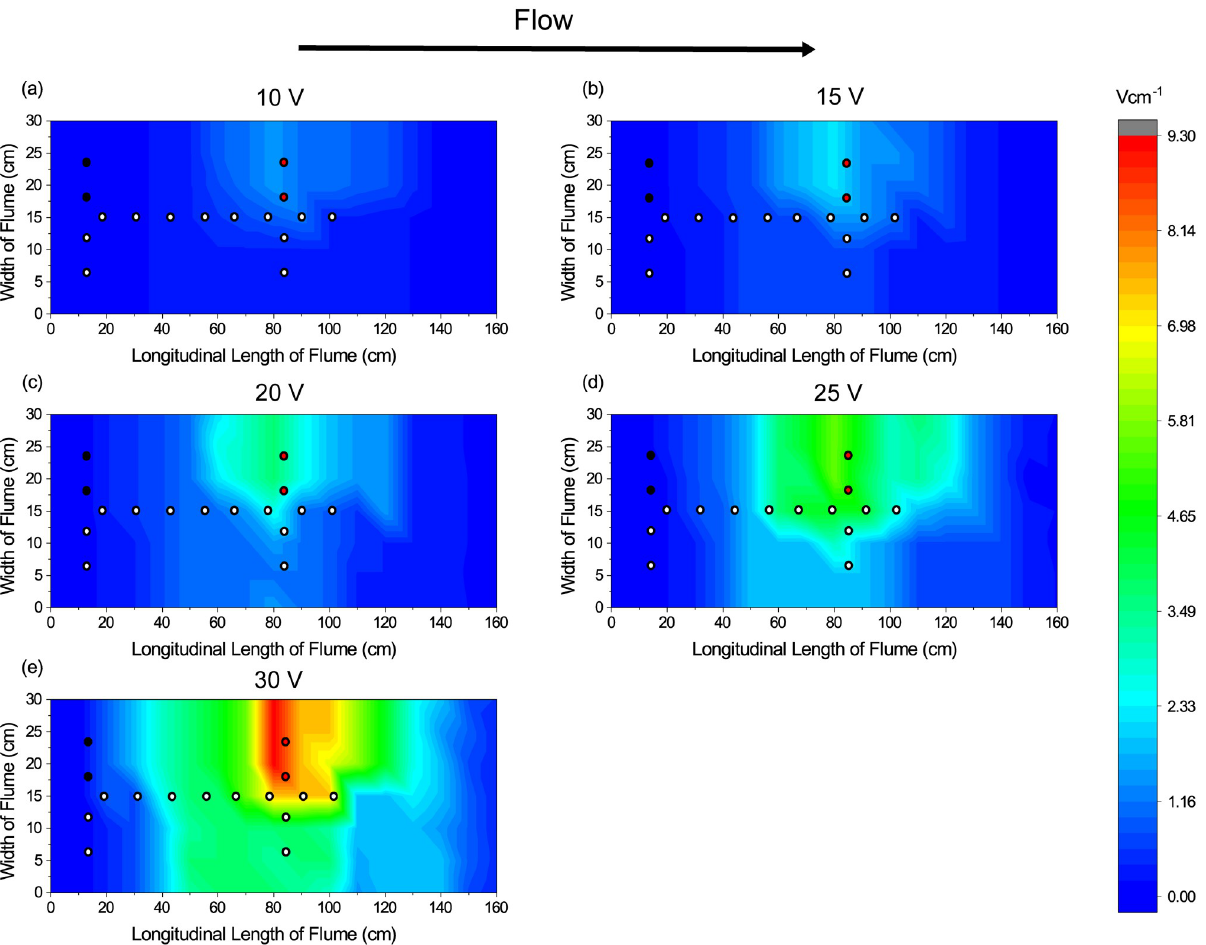
Fig 3. Electric field (Vcm -1 ) generated by the pulse generator output of (maps represent both 2 and 10 Hz frequencies as field distribution was the same): (a) 10 V (Mean HEF Strength: 0.53 Vcm -1 ), (b) 15 V (Mean HEF Strength: 0.77 Vcm -1 ), (c) 20 V (Mean HEF Strength:1.22 Vcm -1 ), (d) 25 V (Mean HEF Strength: 2.17 Vcm -1 ) and (e) 30 V (Mean HEF Strength: 3.74 Vcm -1 ). The x axis represent the longitudinal distance along the flume and the y axis the width of the flume. Centrally earthed electrodes (white dots) were positioned at x = 18, 30, 42, 54, 66, 78, 90, and 102 and at y = 15. Positive electrodes (red dots) were positioned at x = 84 and y = 18 and 24. Negative earthed electrodes (black dots) were positioned at x = 12 and y = 18 and 24. Dummy earthed electrodes (white dots) were at (84, 6) and (84, 12) and (12, 6) and (12, 12). Measurements were taken at 10 cm water depth from the